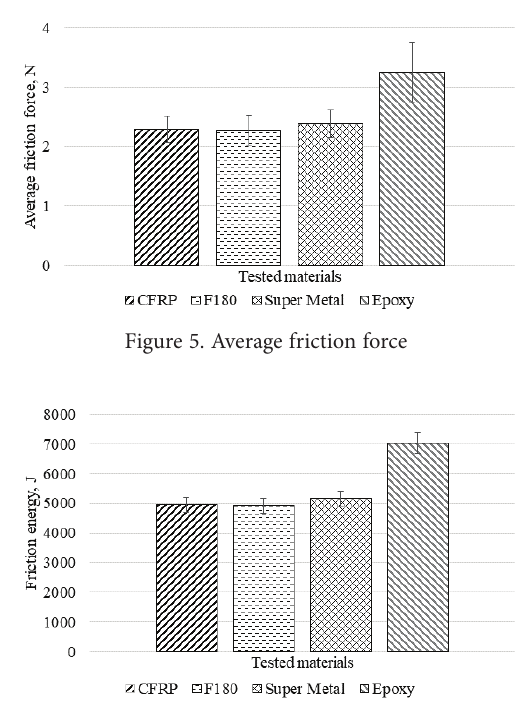
Figure 6. Th e amount of energy dissipated due to friction during the ball-on-disk test